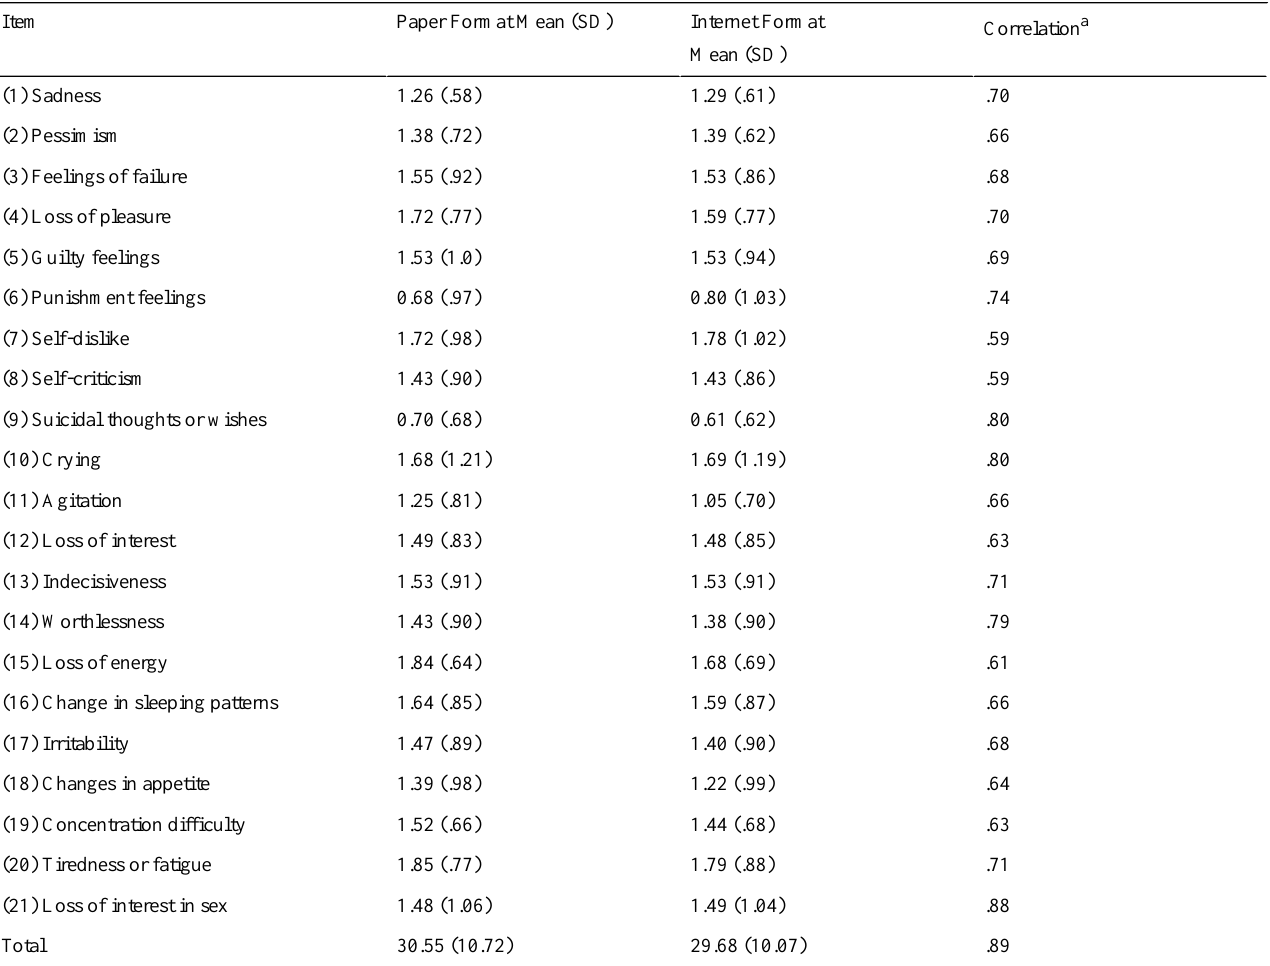
Table 5. BDI-II item, mean score on paper and Internet, and the correlation between them